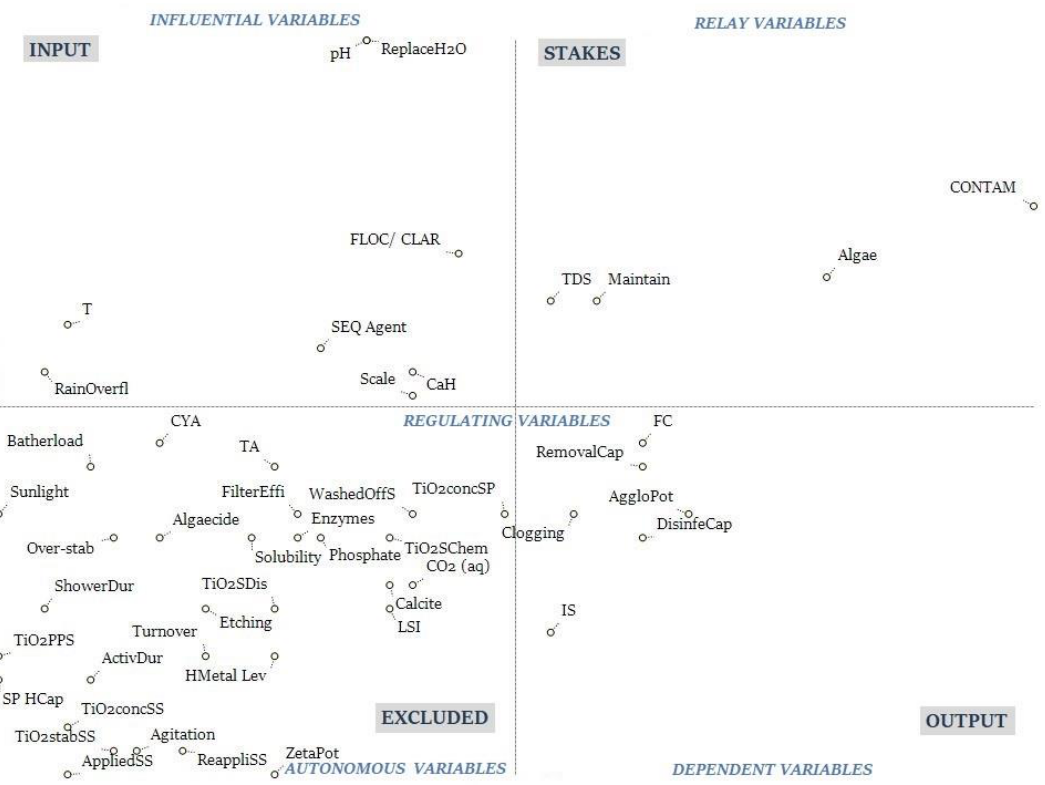
Figure 7. Direct impact map of the model variables, their quadrant allocation and categorisation.